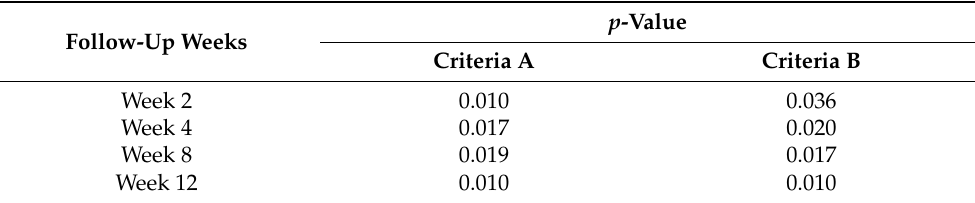
Table 2. Comparison of radiographs following changes in lamina dura around socket (Criteria A) and characteristic of new alveolar bone formation following changes in radiodensity within socket (Criteria B) between the day of operation and 2nd, 4th, 8th and 12th postoperative weeks. p -Value Follow-Up Weeks Criteria A